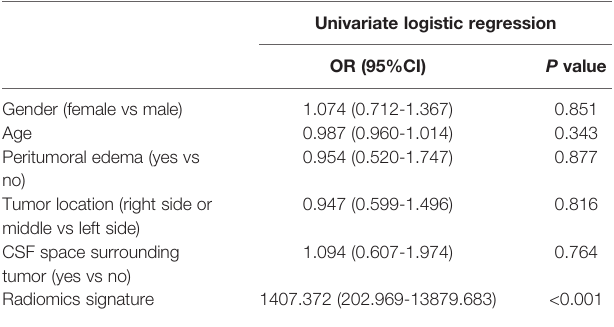
TABLE 4 | The logistic regression results of radiomics signature and clinical risk